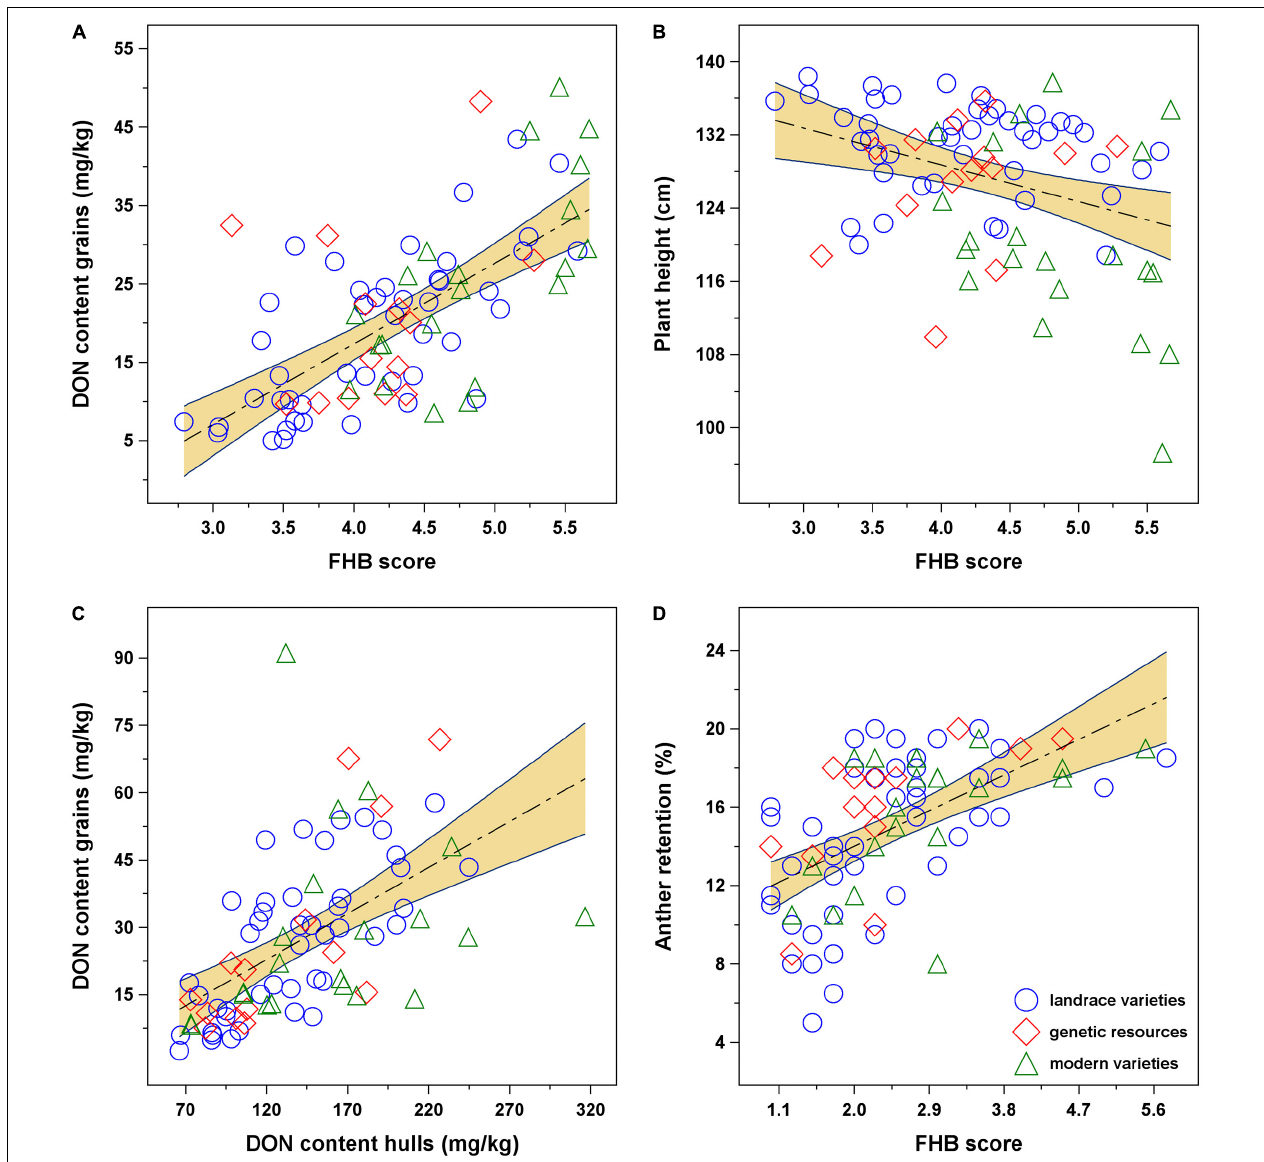
FIGURE 3 | Relationship between Fusarium head blight (FHB) disease-related traits of spelt: (A) disease severity vs. deoxynivalenol (DON) content of grains; (B) disease severity vs. plant height; (C) DON contamination of hulls vs. grains (determined only in CZ17 and CZ18); and (D) disease severity vs. anther retention (determined only in AT17). Landraces and old varieties are represented by blue circles, plant genetic resources by red diamonds, and modern varieties by green triangles. Linear regressions and confidence bands ( α = 0.05) were fitted to all